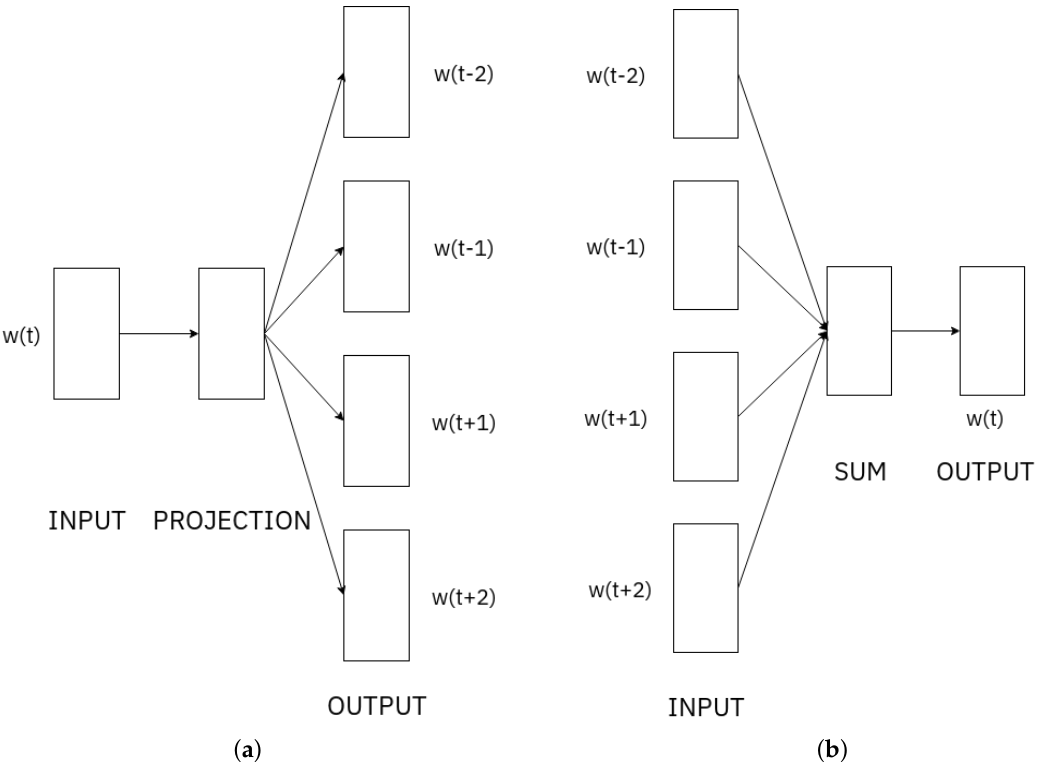
Figure 1. The two architectures for w2v. ( a ) Skip-gram architecture, ( b ) continuos bag of words